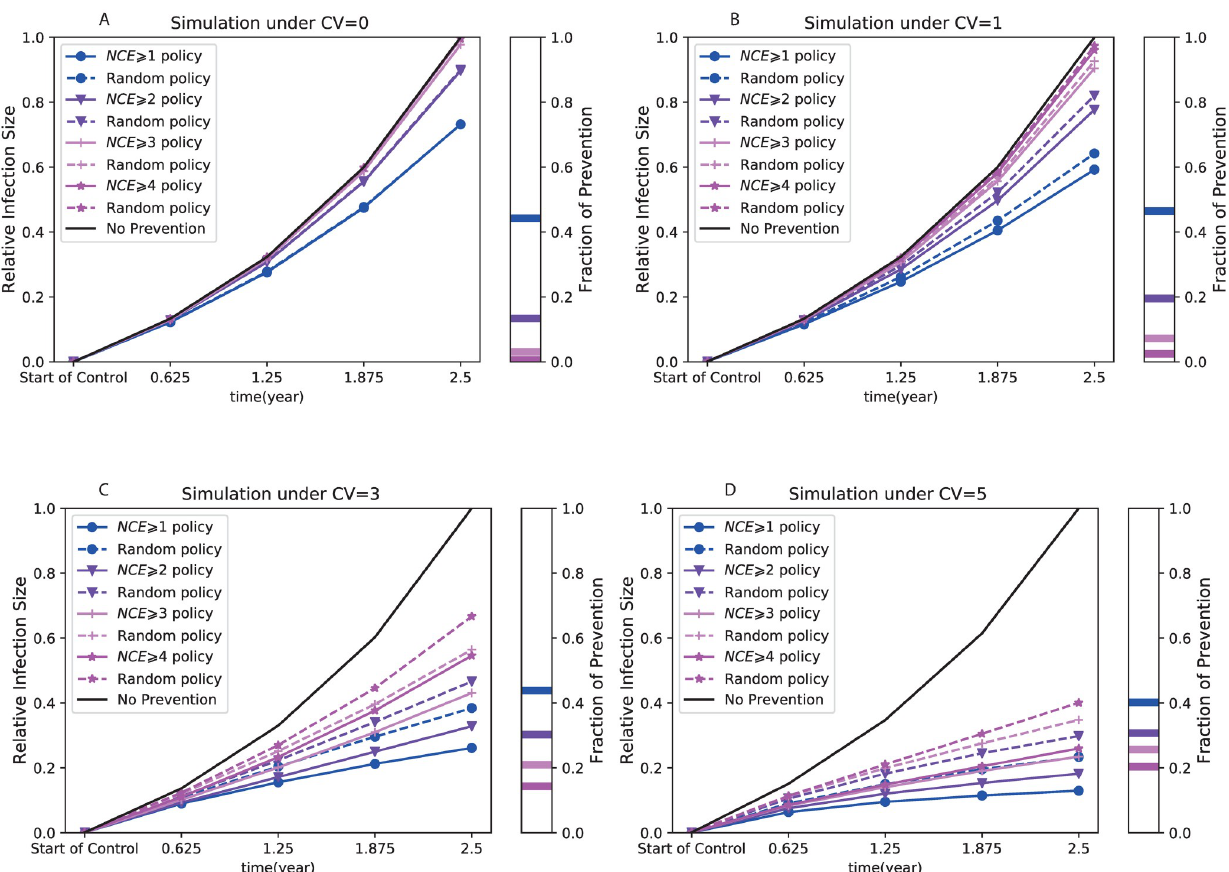
Fig 8. Comparison of NCE -based contact tracing and random contact tracing under the situation of continuous monitoring. The relative infection sizes (defined in S1 Text) of the NCE ⩾ m contact tracing (solid lines) and the corresponding random contact tracing (dashed lines) are compared for four threshold values: m = 1 (lines with ● ), m = 2 (lines with triangledown ), m = 3 (lines with +), and m = 4 (lines with � ). The subplots on the right side of all panels show the fraction of contact traced for all these prevention policies. Four panels show the comparison under four levels of heterogeneity respectively, i.e. CV λ = 0 (A), CV λ = 1 (B), CV λ = 3 (C), and CV λ = 5 (D). These results are the mean of 300 simulations.